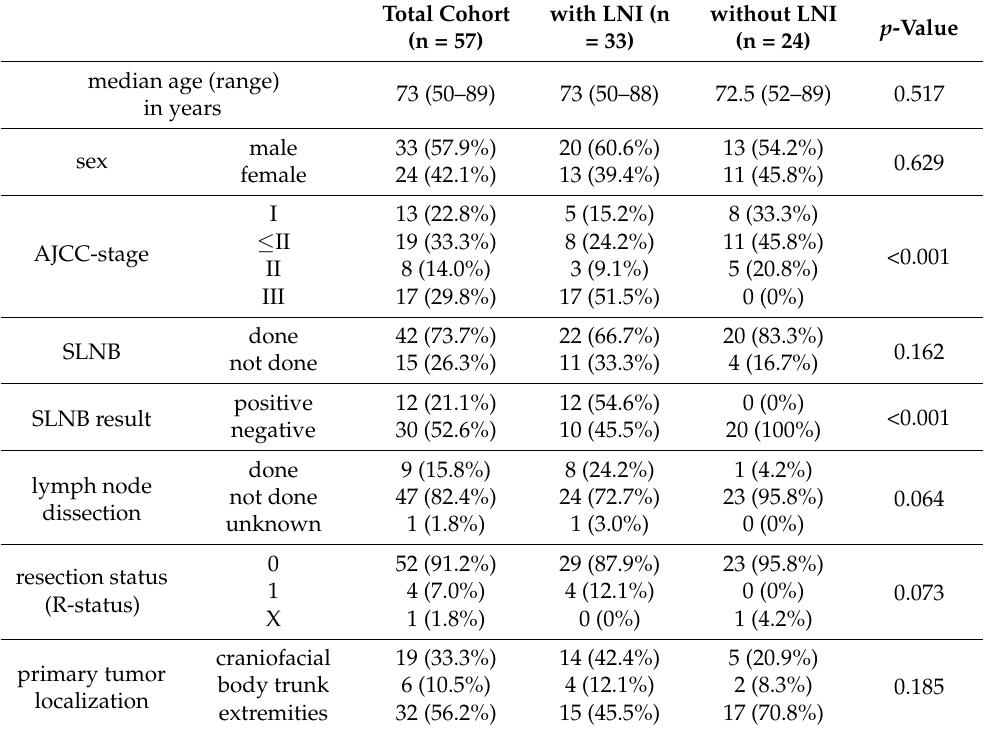
Table 1. Patient characteristics of 57 patients with postoperative radiotherapy for Merkel cell carci- noma (MCC), divided into total cohort and subgroups receiving either radiotherapy of the tumor bed without lymph node irradiation (without LNI) or with additional irradiation of the lymph nodes (with